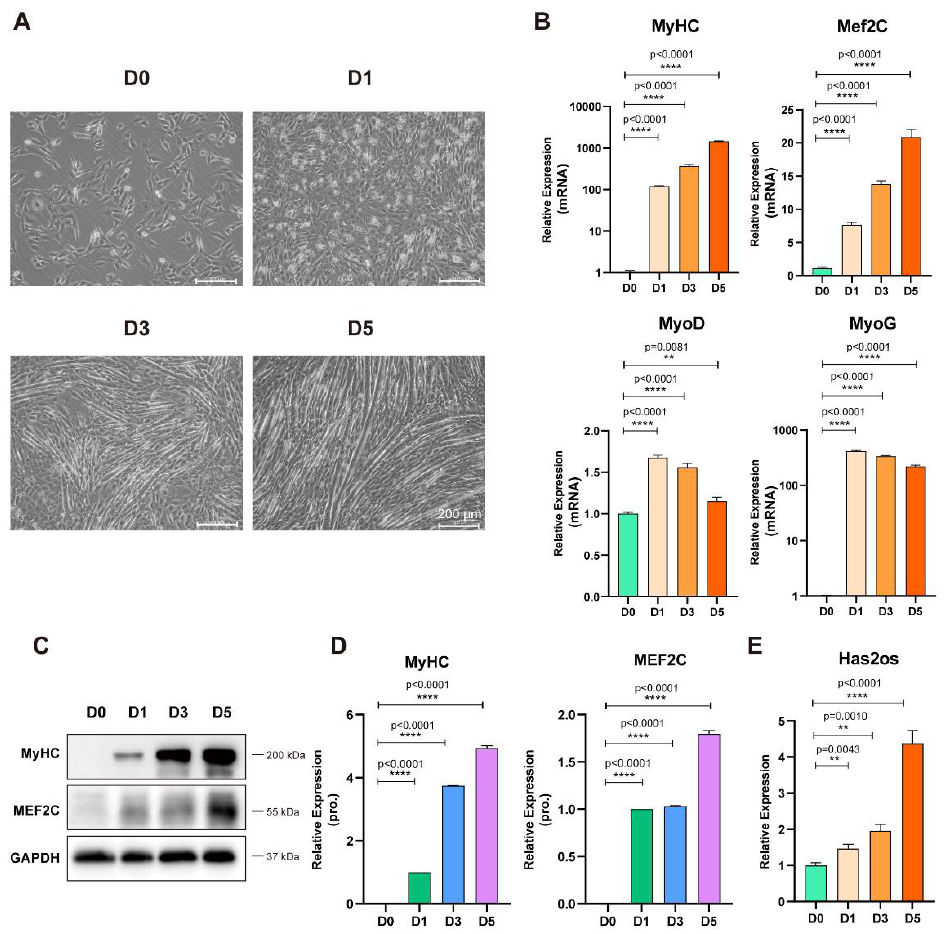
Figure 2. Has2os expression was increased in differentiated muscle cells. ( A ). The morphological changes in C2C12 cells before and after differentiation. D0 represents cells in growth medium, and D1, D3, and D5 represent cells switched into differentiation medium for 1, 3, or 5 days. Scale bar = 200 μm. ( B ). The mRNA expression levels of the myogenic marker MyHC, Mef2C, MyoD, and MyoG were measured before and after the differentiation of C2C12 cells. ( C ). The protein expression levels of myogenic markers MyHC and MEF2C were detected by Western blot. GAPDH was the internal control. ( D ). Relative expression in ( C ) were calculated. ( E ). The expression levels of Has2os in D0, D1, D3, and D5. GAPDH was the internal control. Values were presented as means ± SEM. The statistical significance was calculated by t